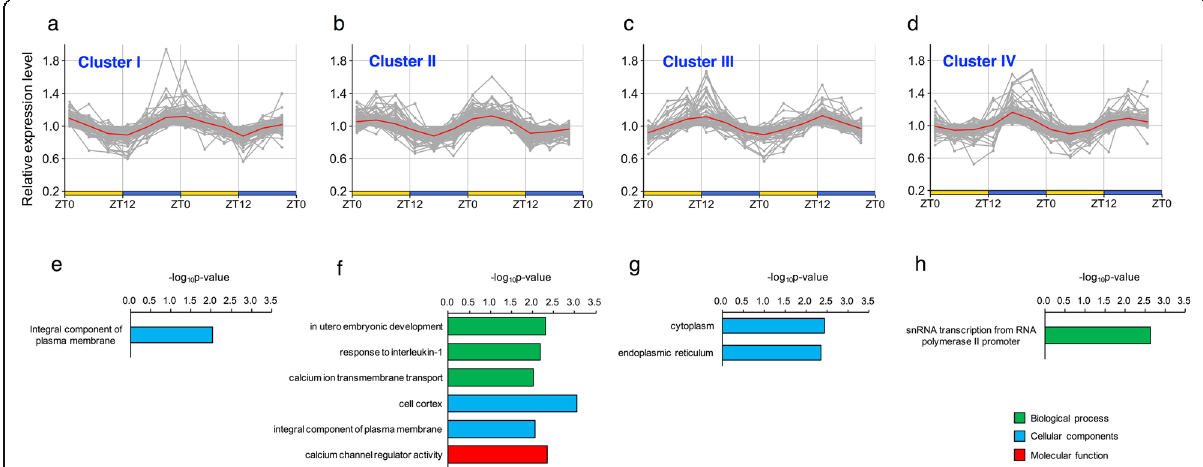
Fig. 4 Characterization of diel cycle genes a , b , c , d Oscillation patterns the clusters identified by K-means clustering. The red line indicates the mean intensity of the clustered genes. e , f , g , h GO terms enriched in Cluster I, Cluster II, Cluster III, and Cluster IV. The p -values represent the modified Fischer exact P values